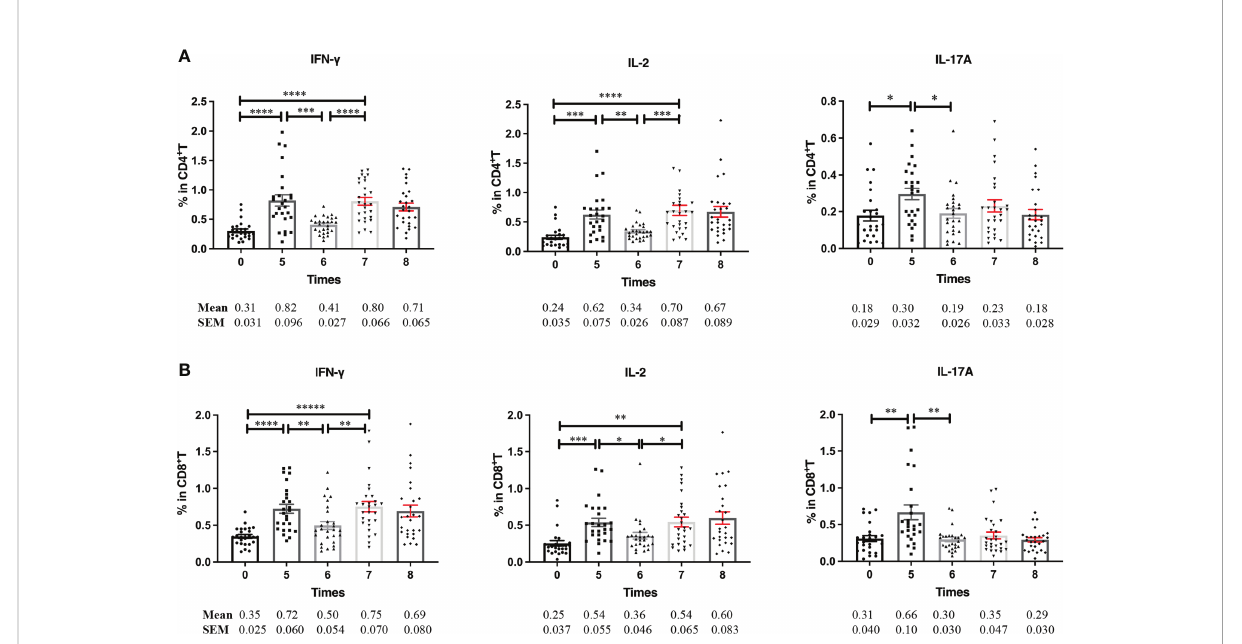
FIGURE 3 PPD-speci fi c cytokine production in T cells at the maintenance phase. (A, B) Frequencies of PPD-speci fi c IFN- g , IL-2, and IL-17A releasing CD4 + (A) and CD8 + (B) T cells at the induction and maintenance phases. Blood samples were collected serially from BCG responding patients (n = 27) before each BCG instillation at the induction and maintenance phase. PBMCs were prepared and stimulated with PPD for further fl ow cytometric analyses. Data are represented as the mean ± SEM. P values were calculated using analysis of variance. * P < 0.05, ** P < 0.01, *** P < 0.001, **** P <